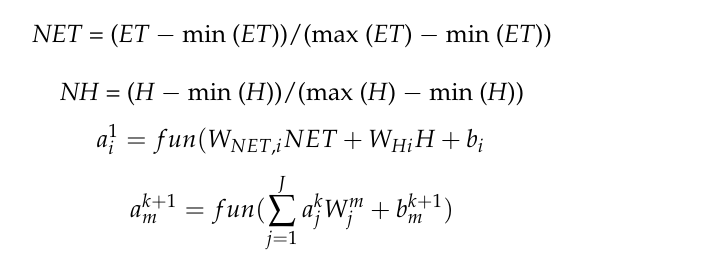
Figure 2. The structure of the neural network. The structure of the neural network included daily crop evapotranspiration (ET) and groundwater depth (H) in the input layer, which were normalized using Equations (1) and (2). Normalized data were fed into the first hidden layer. There are I nodes in the first hidden layer, and the calculation is shown in Equation (3). All outputs of the I nodes were fed into the second hidden layer, and the results were calculated using Equation (4). Then, the outputs of the k th hidden layer were fed into the k +1th hidden layer using Equation (4), and there were K hidden layers. Finally, the results were obtained for the output